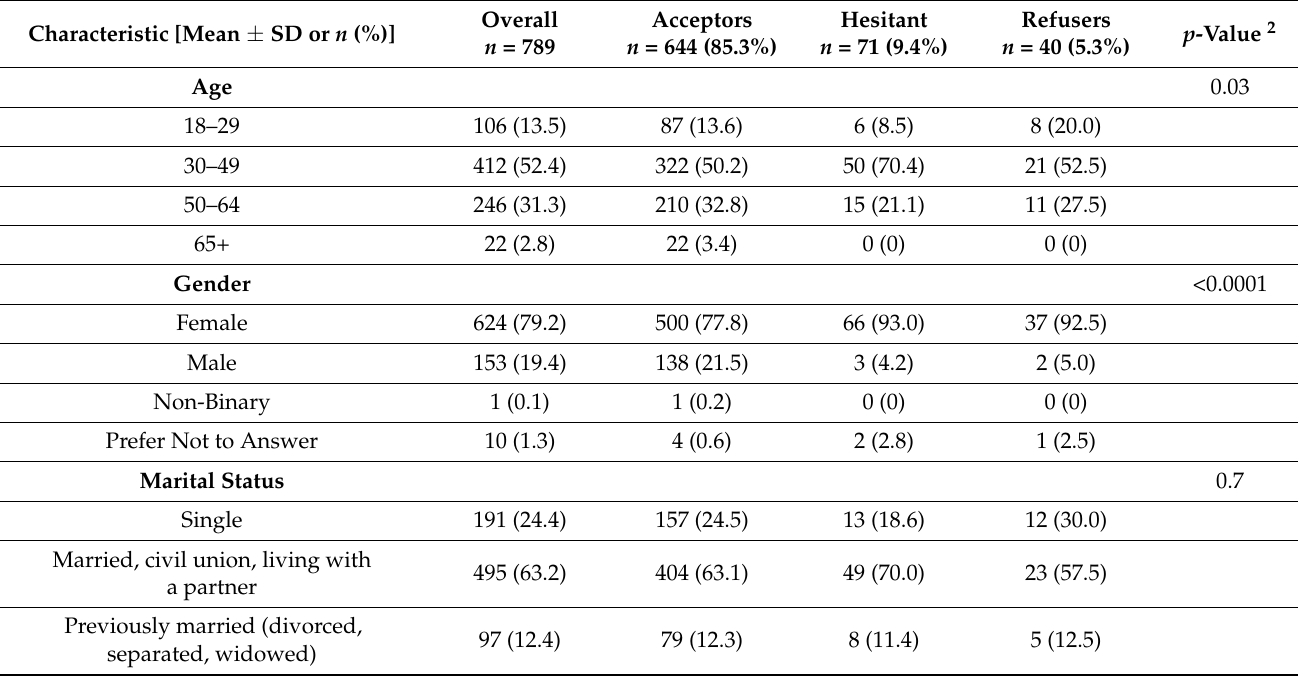
Table 1. Characteristics of RUHS Medical Center Employees ( n = 789) who Participated in COVID-19 Vaccine Survey, by Vaccine Acceptance Status (Acceptors, Hesitant,